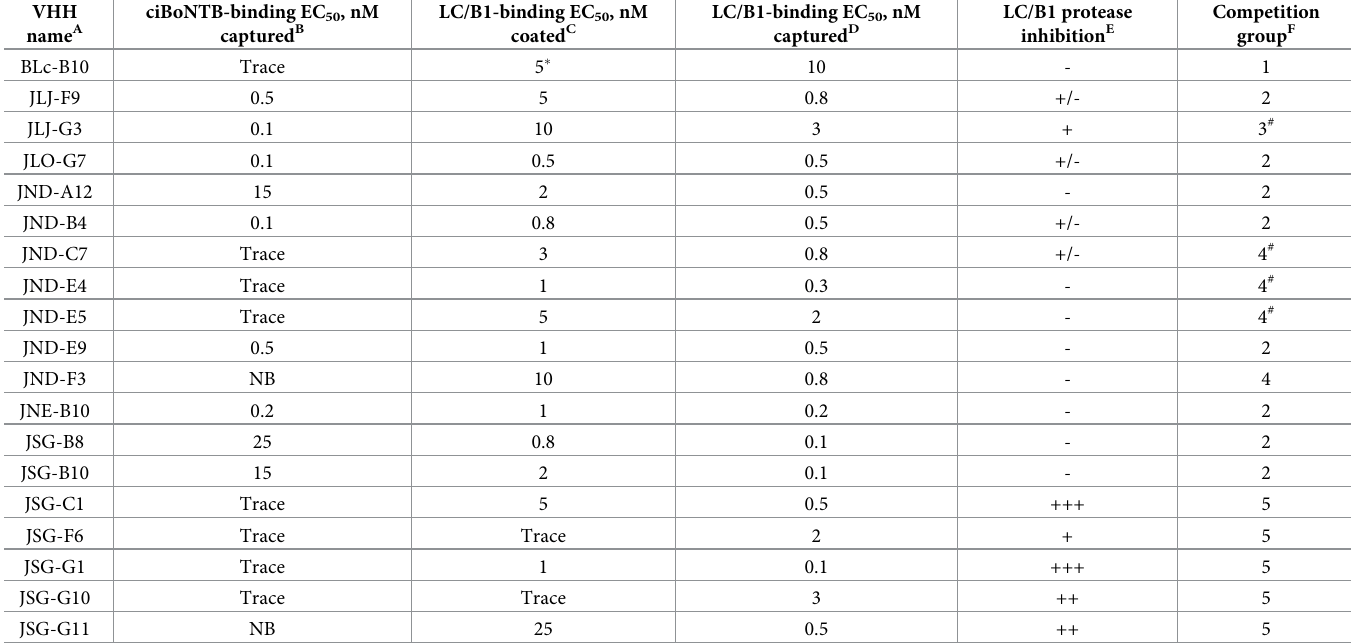
Table 2. A summary of anti-BoNT/B VHH characterization